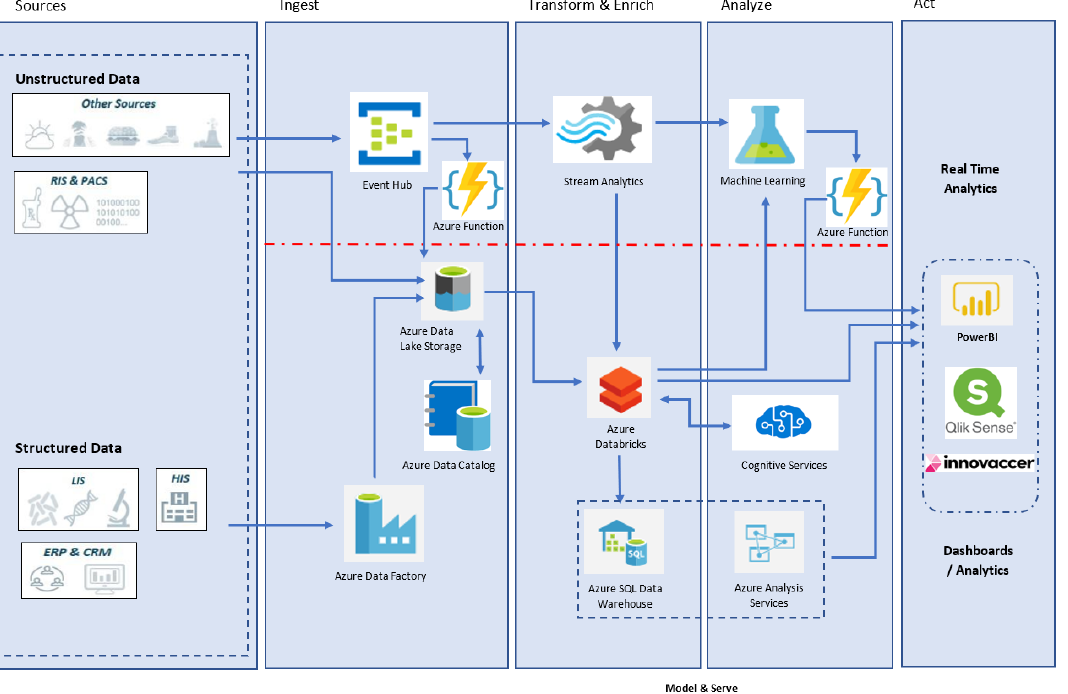
Figure 2. Azure Big Data and Machine Learning Lambda